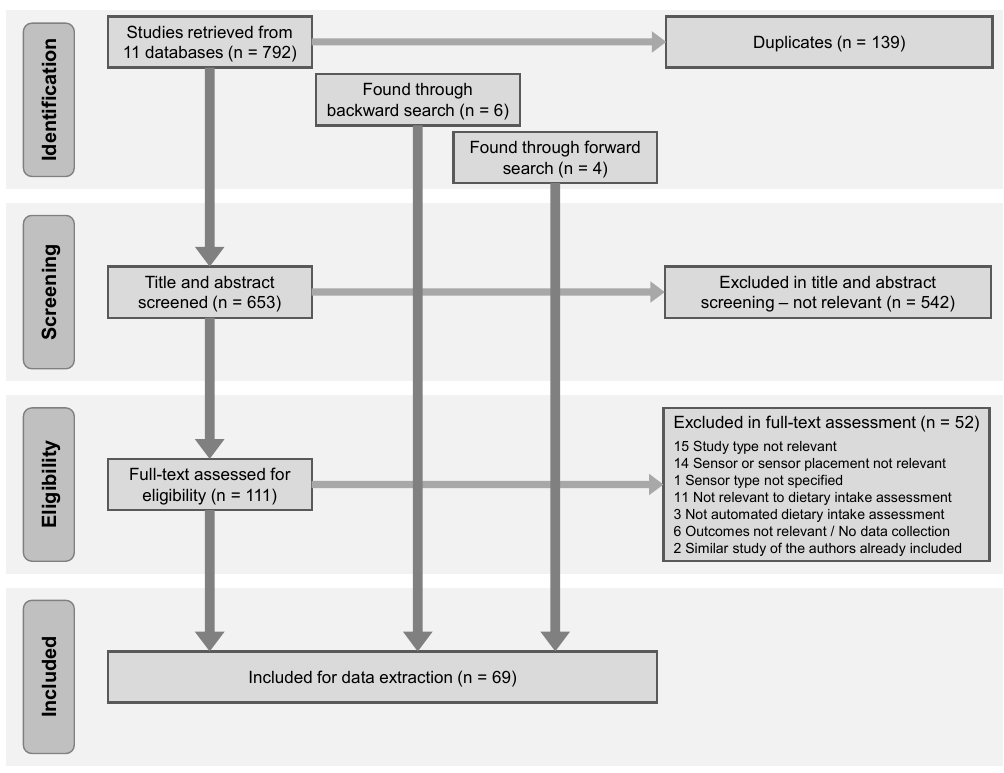
Figure 1. Flow diagram of article selection process in the systematic review.